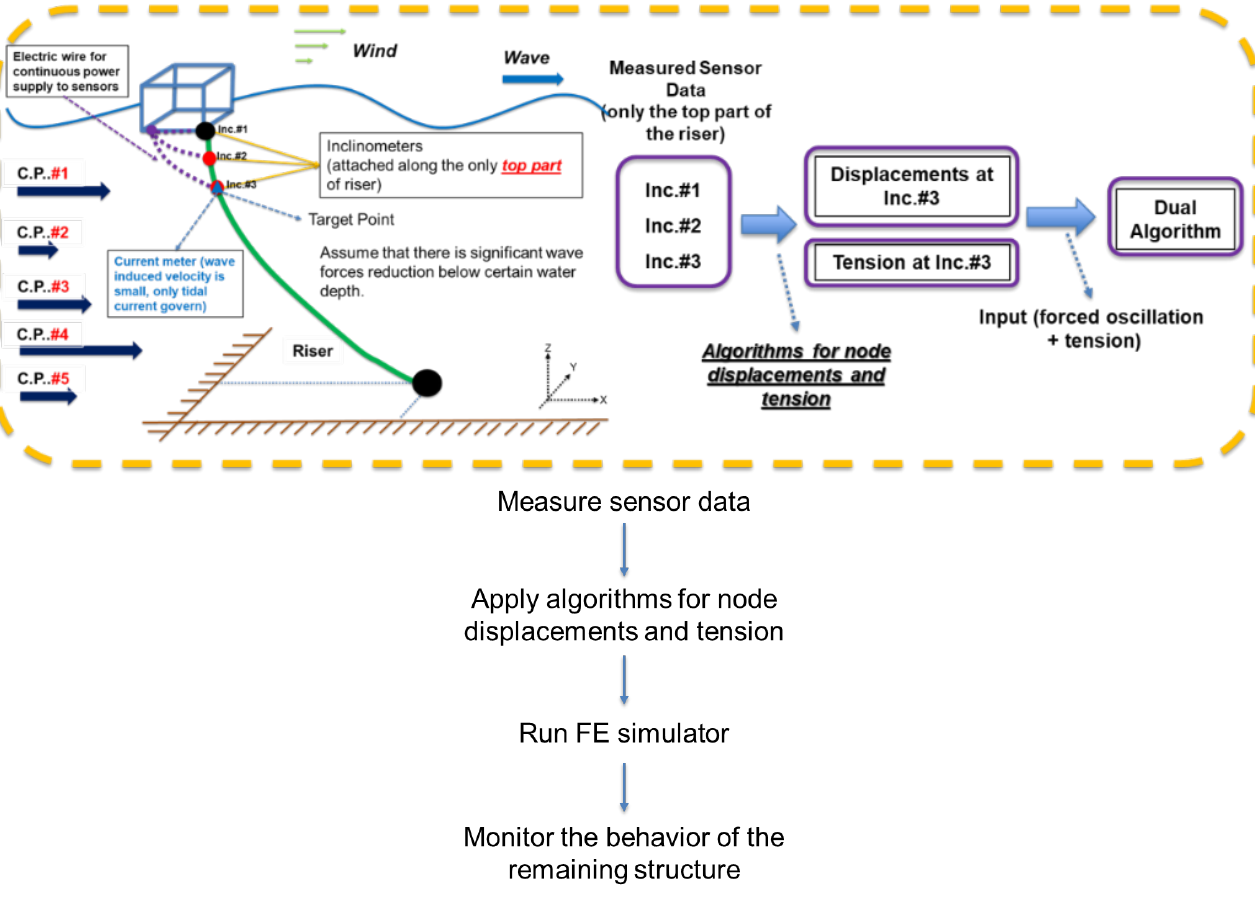
Figure 5. Scheme View ( top ) and Flowchart ( bottom ) of Dual-Algorithm Model for Riser Health Monitoring with Minimum Sensors.